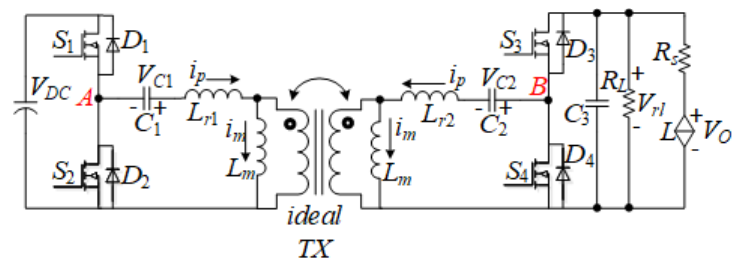
Figure 7. Reverse equivalent